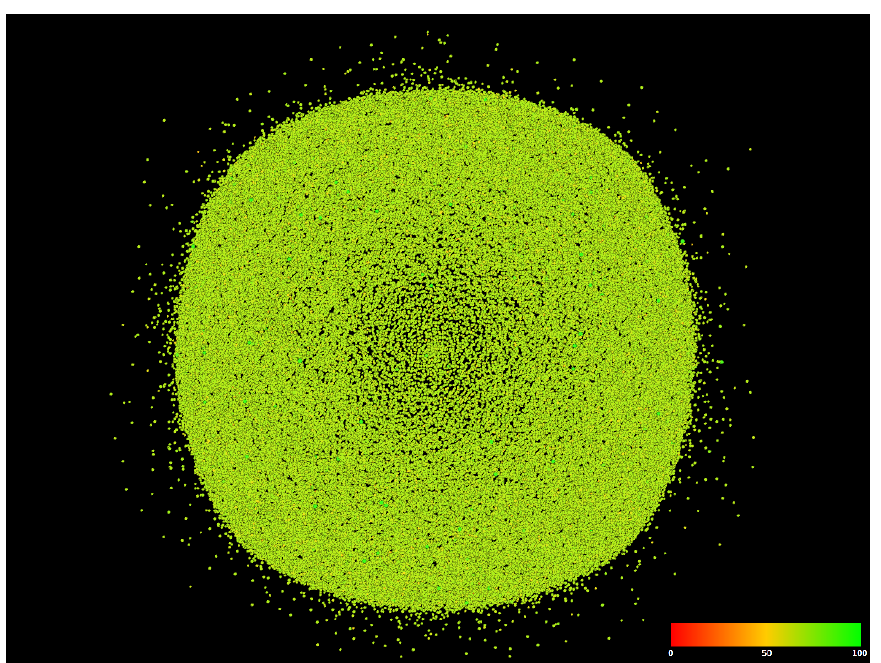
Figure 3. Idle times per router, energy-aware